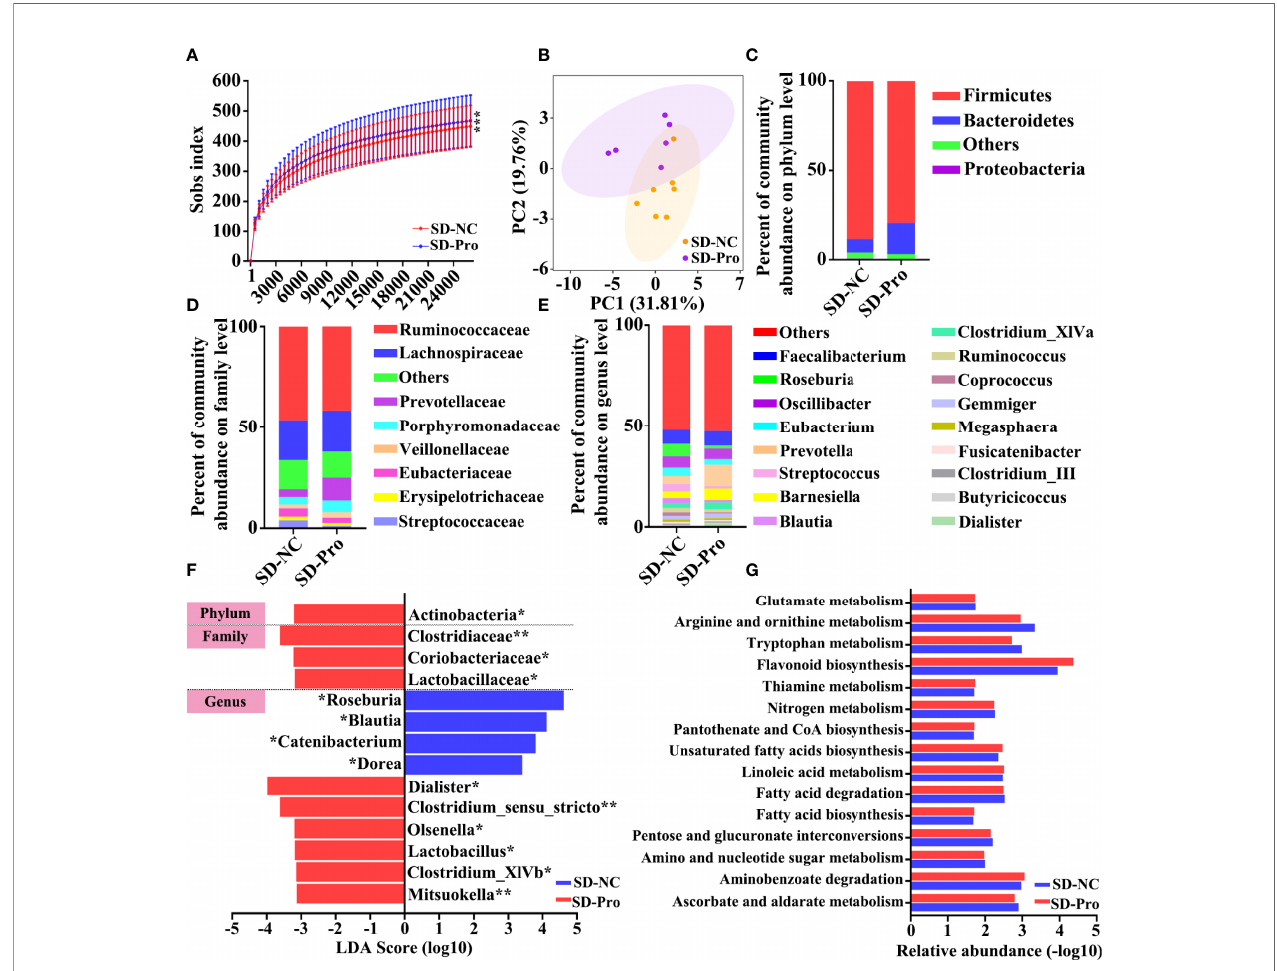
FIGURE 5 | Composition of gut microbiota after probiotics supplementation in sleep deprivation (SD) rhesus monkeys (RMs). (A) Rarefaction curves for the gene number in the control ( n = 7) and probiotics supplementation ( n = 6) groups. (B) Principal coordinate analysis showed that SD RMs with probiotics supplementation were signi fi cantly different from those controls. The relative abundance offecal bacteria at phylum (C) , family (D) , and genus (E) levels was clustered into different groups. Only phyla meeting relative abundances of more than 0.5% was recruited in this analysis. (F) The differential bacteria between probiotics and the control group were identi fi ed by LEfSe methods. The probiotics-enriched taxa were indicated with a negative LDA score (red), and the control enriched taxa were indicated with a positive LDA score (blue). (G) The fi fteen differential KEGG pathways based on differential gut microbiota were shown. Differences were denoted as follows: * p < 0.05; ** p < 0.01; *** p < 0.001. SD-NC, SD control group; SD-Pro, SD group with probiotics